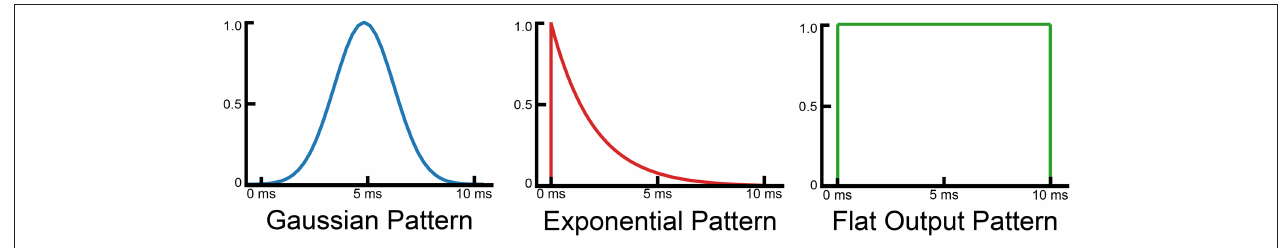
FIGURE 2 | Diagram showing different training patterns used to train the SKIM